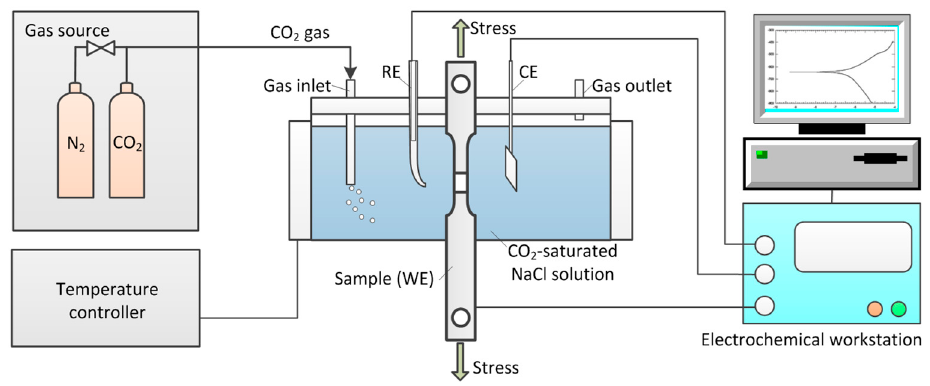
Figure 3. Schematic of the experimental set-up for the electrochemical measurement on the tensile